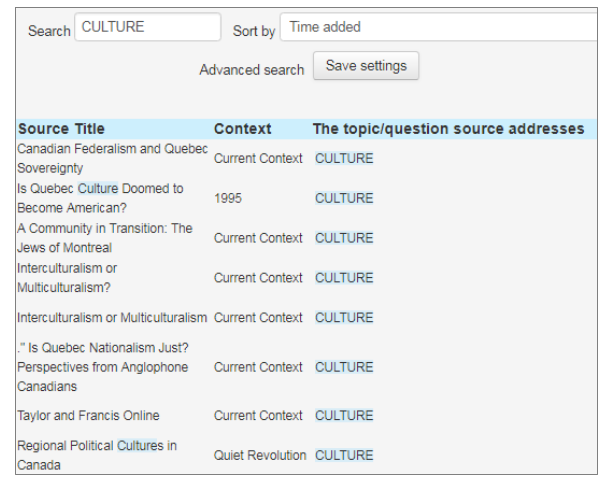
Figure 6. Searching and sorting based on source attributes in Moodle database activity.